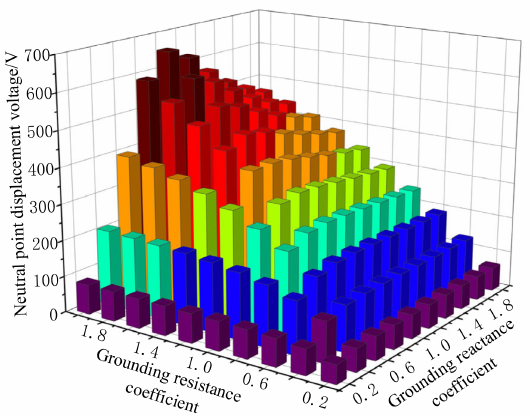
Figure 11. Variation diagram of neutral voltage drift with grounding